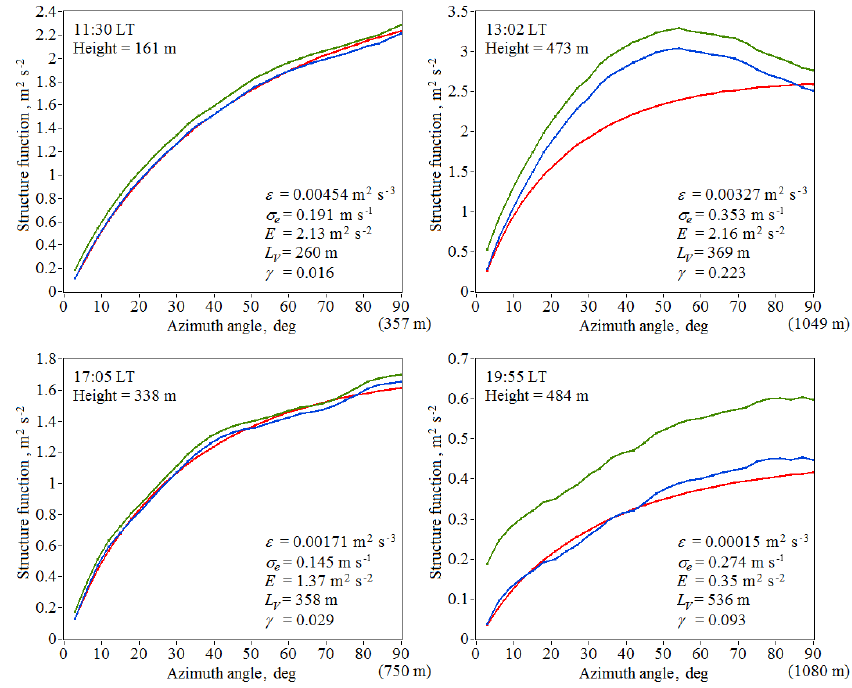
Figure 12. Examples of the azimuth structure functions D L (ψ l ) (green curves), D L (ψ l ) − 2 σ 2 e (blue curves), and D a (ψ l ) (red curves) obtained from measurements by the Stream Line lidar on 22 July 2016. The D a (ψ l ) functions were calculated by Eqs. (18), (20), and (27) with the use of experimental values of ε and L V . The arc length in the base of the scanning cone y k = (π /180 ◦ ) ψ l h k / tan ϕ E at ψ l = 90 ◦ is given in parenthesis.